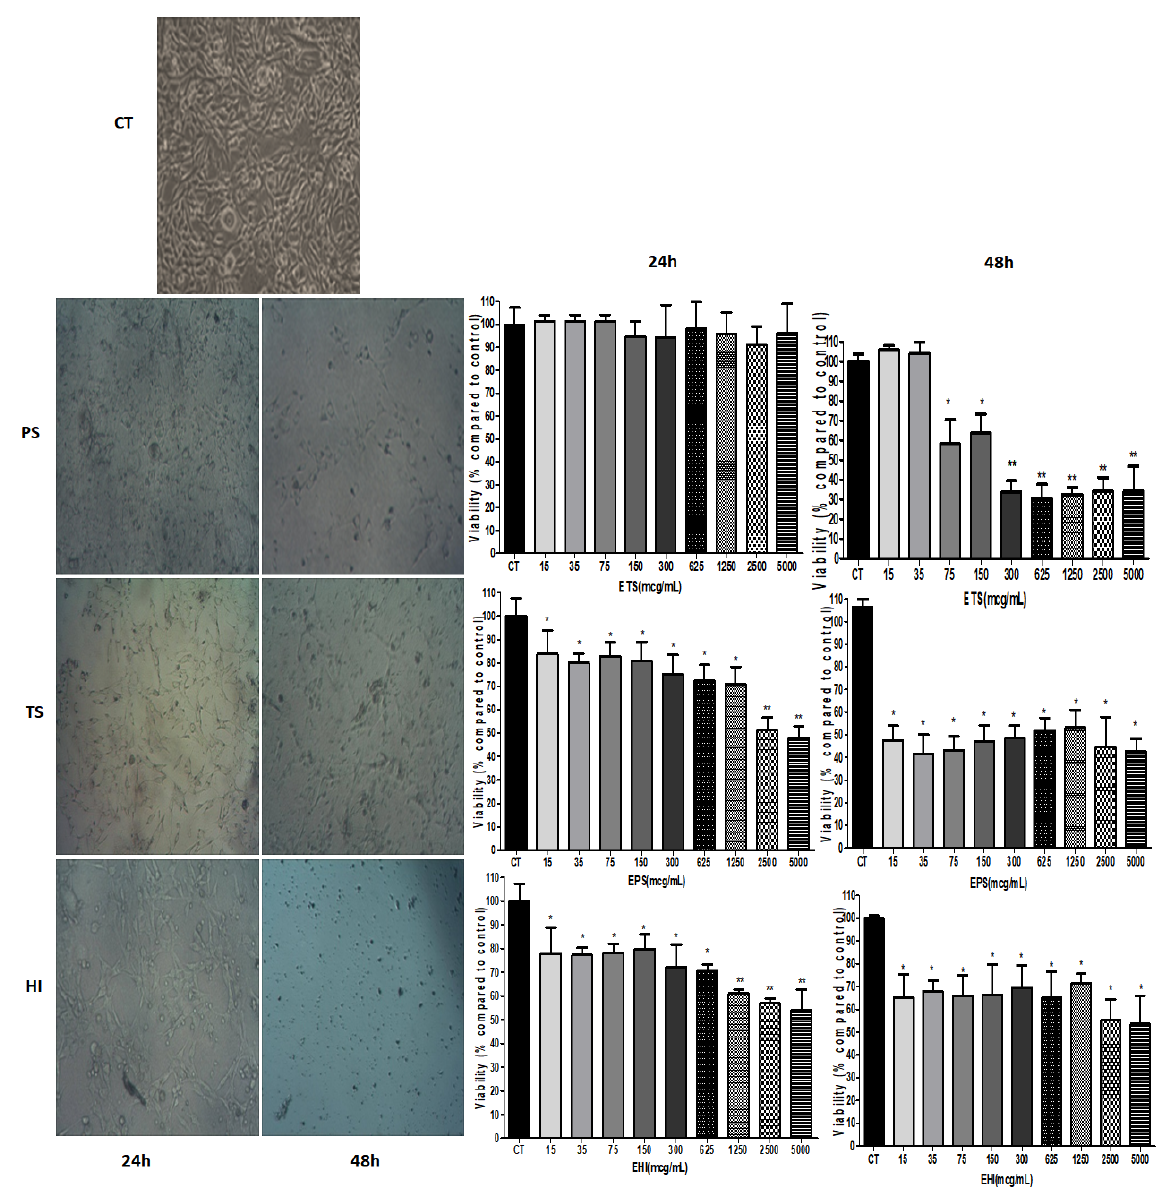
Figure 1. Effect of Tsumori (TS), Pedro Sato (PS), and Hitígio (HI) guava extracts (15-5000µg /mL) on MDA-MB -435 cells viability after 24 and 48 hrs treatment. Results were compared by One- way ANOVA test and Tukey test (* p<0.05; ** p <0.01). CT= Results of untreated (CT) and treated